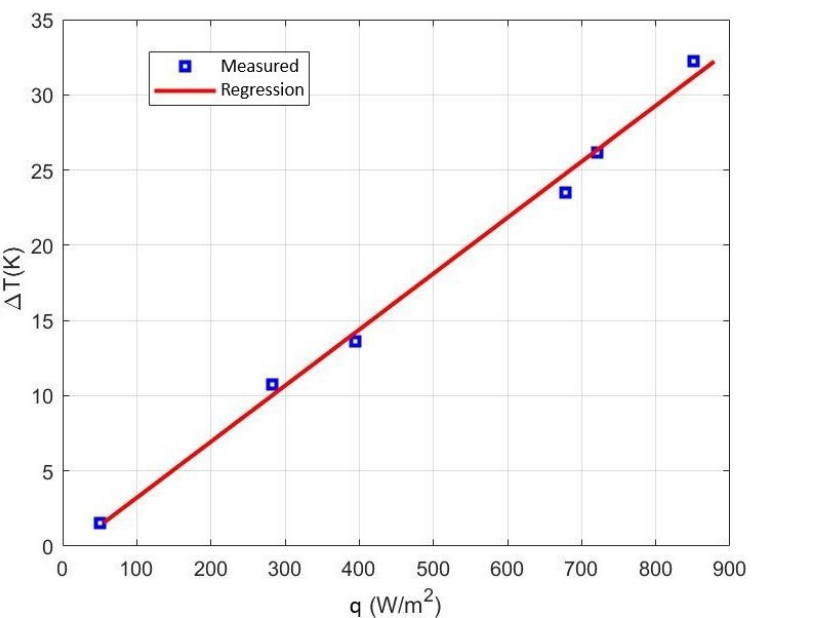
Figure 10. Temperature gradient between both sides of the 3D-printed sensor as a function of the applied heat